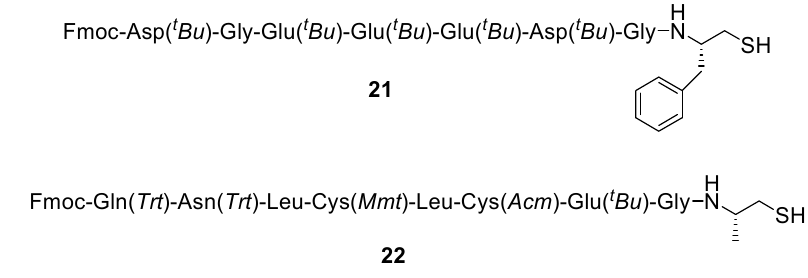
Figure 3. Structure of thiol-peptides 21 (ProTa (69-75) derivative) and 22 (Hirudine (11-18) derivative), synthesized on Trt-resins 19 (R’ = CH 3 ( 21 ); –CH 2 –Ph ( 22 )).